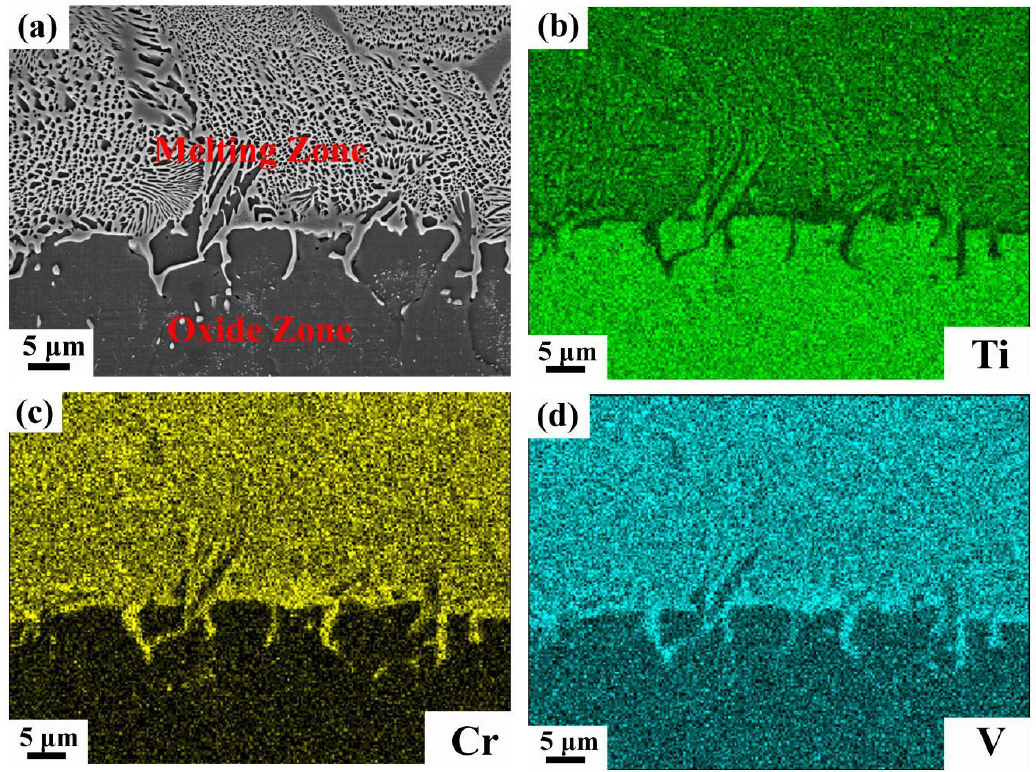
Figure 6. SEM photograph of typical microstructure of oxide zone and melting zone ( a ), and the corresponding mapping-scan of EDS analysis, containing ( b – d ) for Ti, Cr and V atomic distributions, respectively.